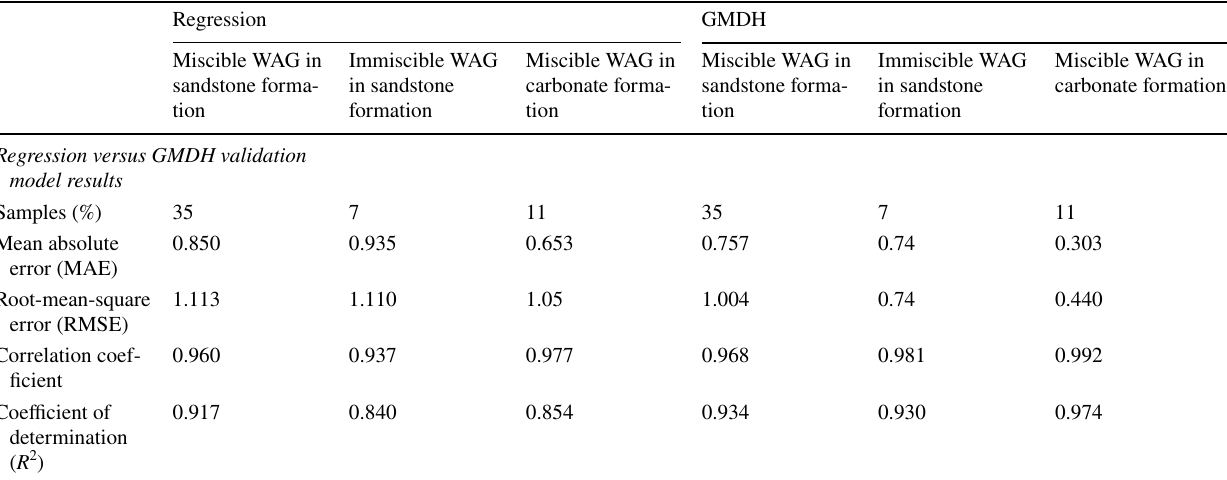
Table 7 Summary of the two prediction model results: training set Regression